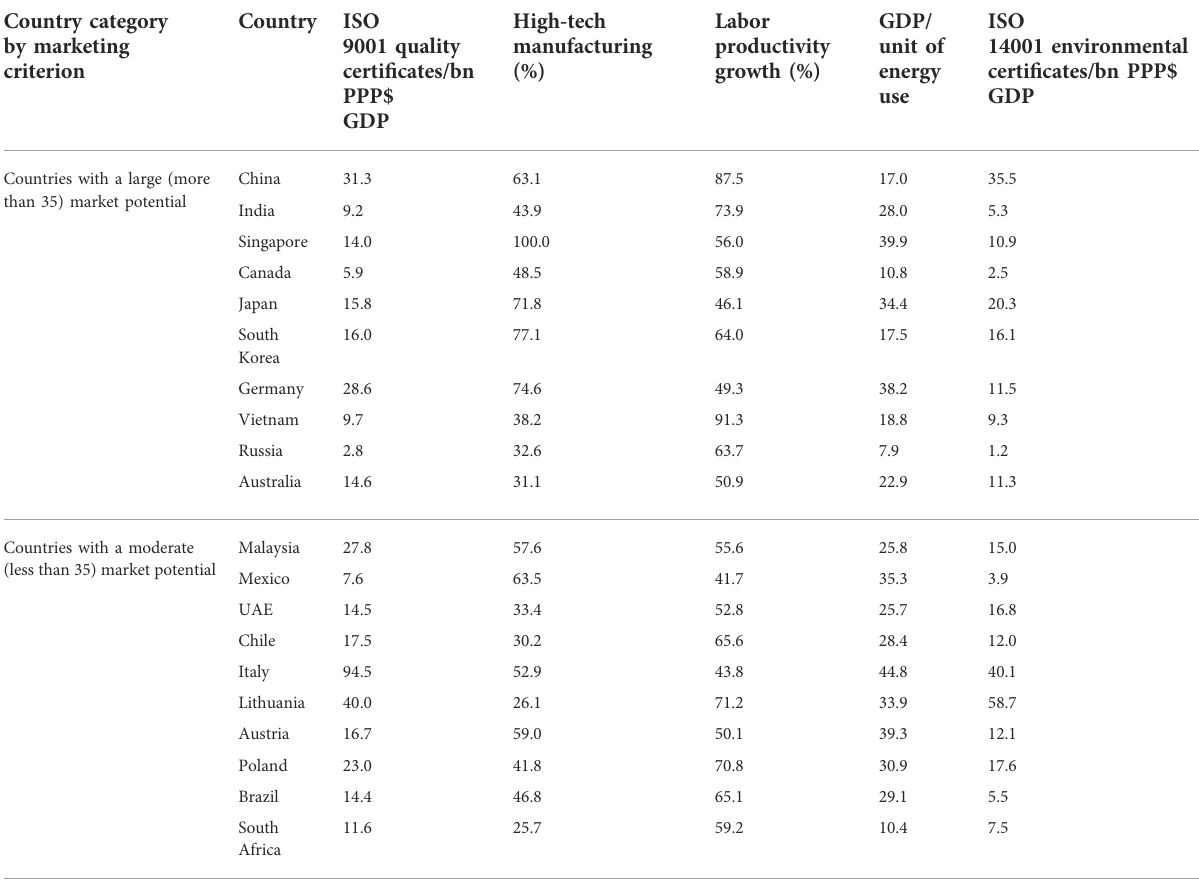
Country category by marketing